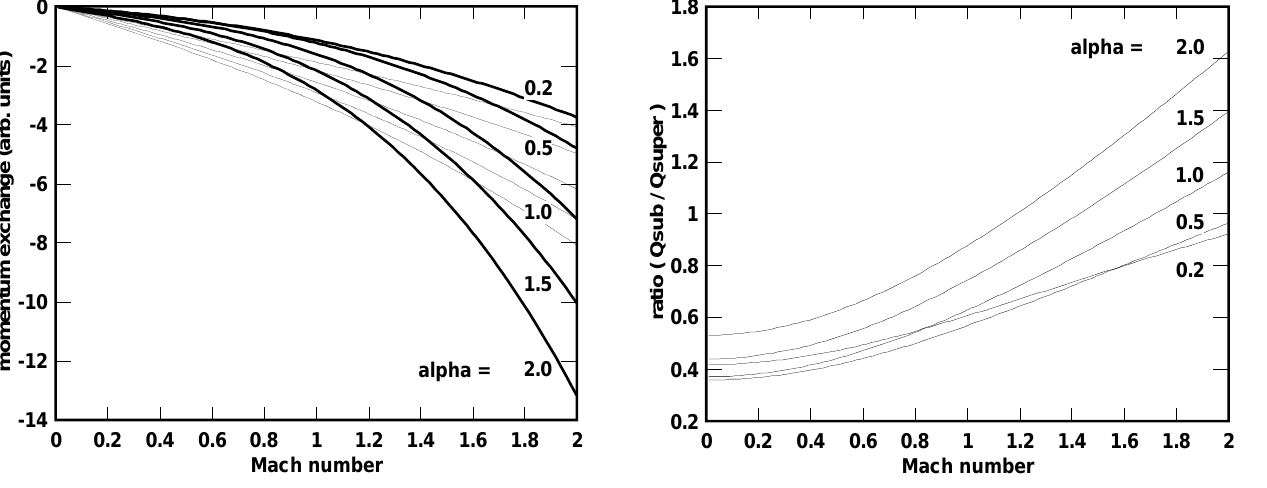
Fig. 2. Shown as a function of the H-atom flow Mach number M H are both the net momentum exchange rates Q super and Q sub , in units of the quantity 5 defined in the text, for various values of the temperature ratio α = T H /T p .